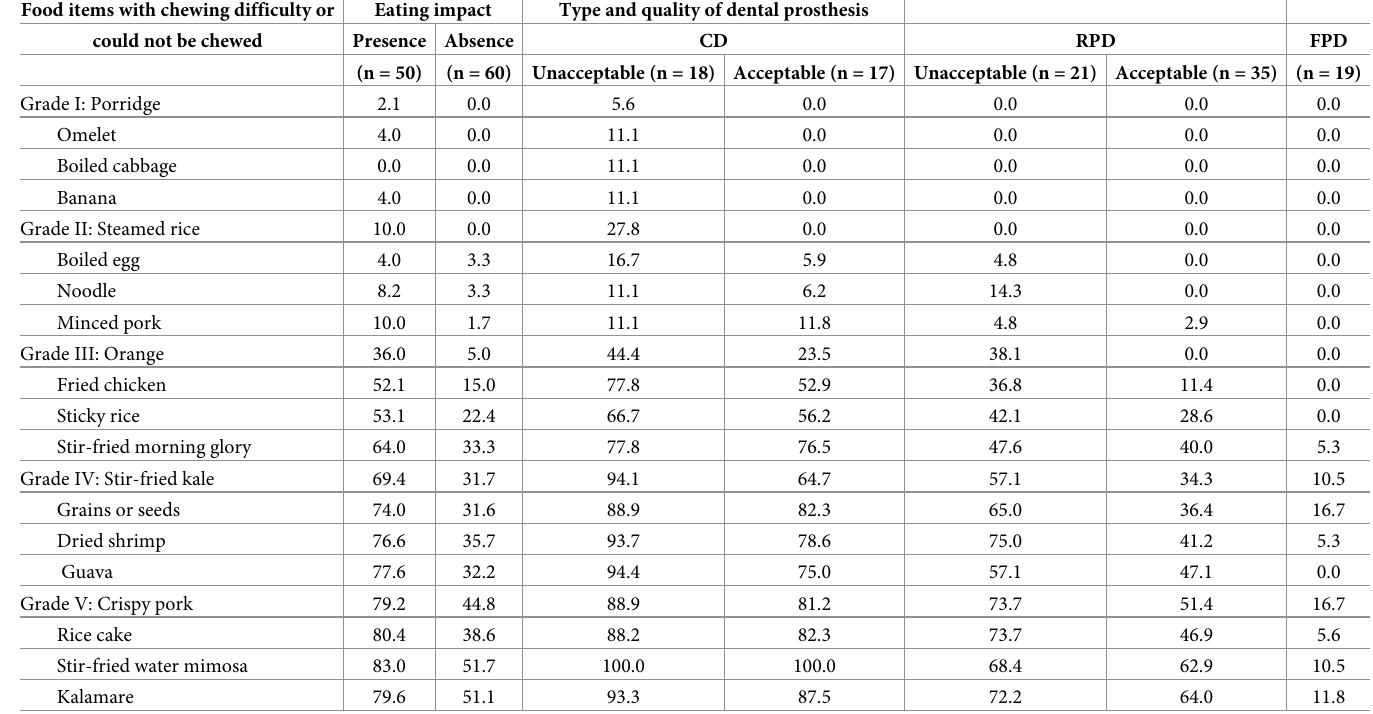
Table 4. Food items with chewing difficulty or could not be chewed according to different status of eating impact, type and quality of dental prosthesis. Food items with chewing difficulty